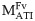
Isometric active force—length relations of the different models.Models MATIFv and MATI reproduce the force—length relation as proposed in [1] that is included at the half-sarcomere level of all models. Models MFv and Mxx predict different forces on the descending limb. Under steady-state conditions (after 2.5 s) the results of models MFv and Mxx, as well as those of models MATIFv and MATI, coincide.